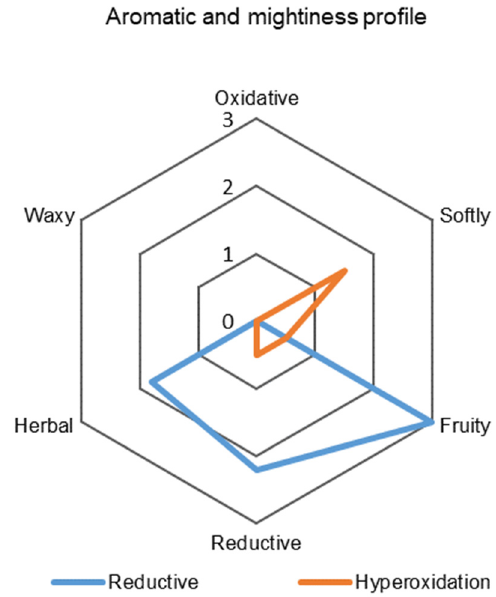
Figure 6. Aromatic and mightiness profile comparison of the result of reductive (RED) and hyper- oxidized (HOX) Hibernal grape processing. The values on the graph are averages from eight eval- uators.